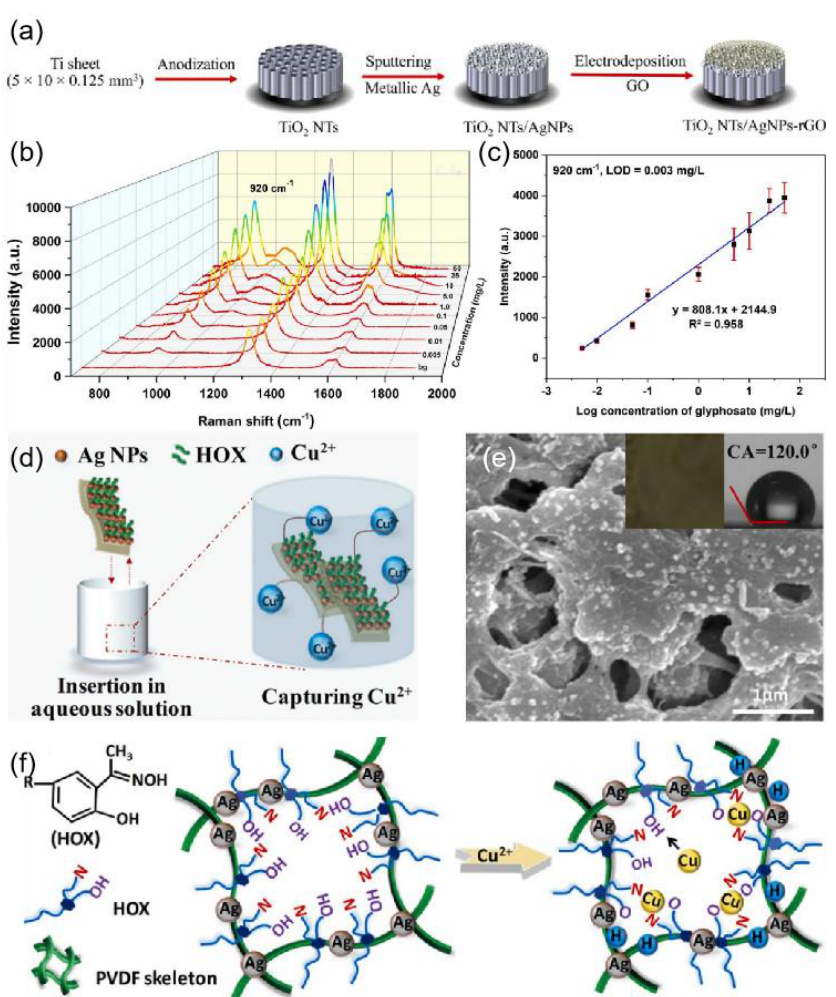
Figure 14. ( a ) Fabrication of the TiO 2 NTs/AgNPs-rGO hybrid SERS substrate. Reprinted with permission from Ref. [150]. Copyright 2022, Journal of Hazardous Materials. ( b ) Raman spectra of